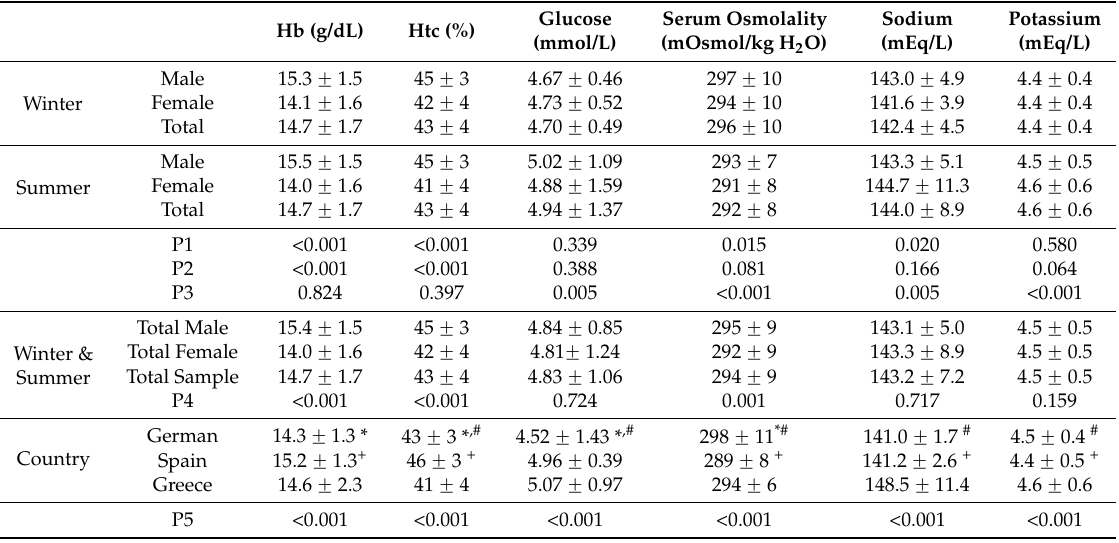
Table 2. Blood and serum hydration indices of participants in winter and